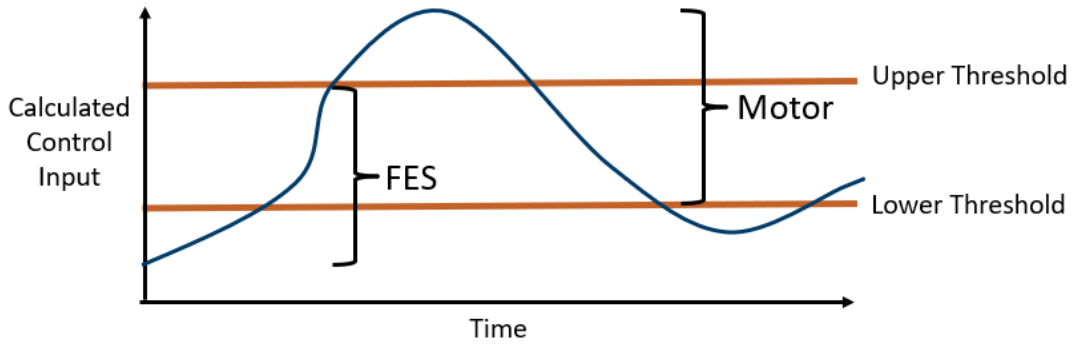
Figure 1. For a given calculated control input and set of FES thresholds, the diagram shows whether FES, motor, or both will control the forearm